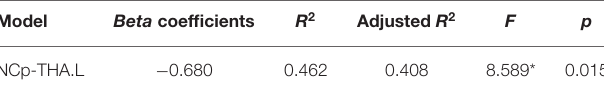
TABLE 4 | Results of stepwise regression of topological parameters changes with cognitive flexibility changes.